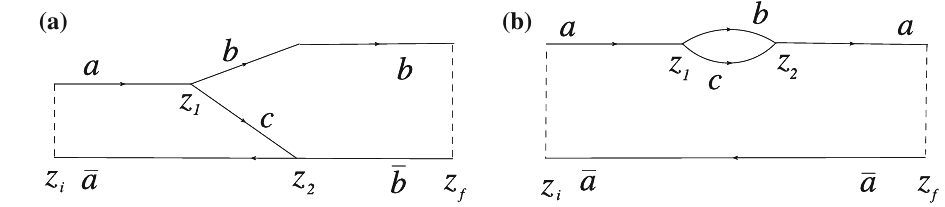
a → bc → a . There are also similar diagrams with transposition of vertices between the upper and lower parts of diagrams a and